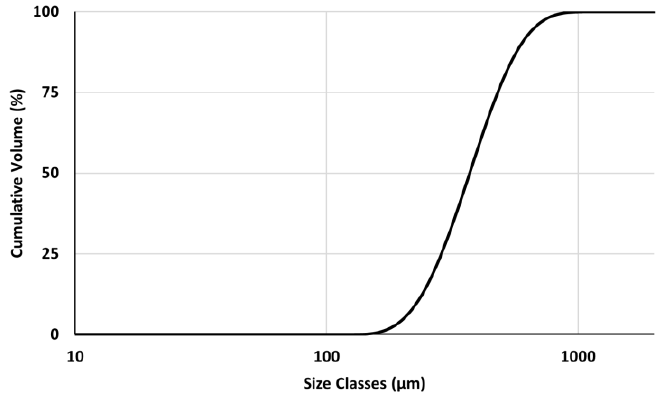
Figure 4. Cumulative PSD curves for sand used as fine aggregates. Table 3. PSD D10, D50, and D90 parameters for sand used as fine